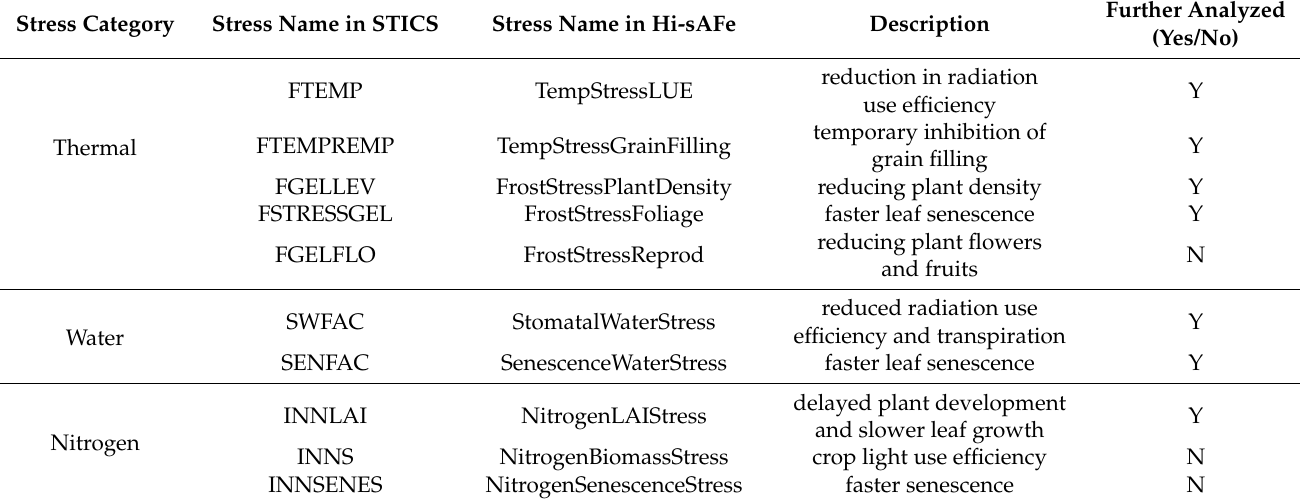
Table 1. Thermal, water, and nitrogen stresses active on the crop in the Hi-sAFe model.